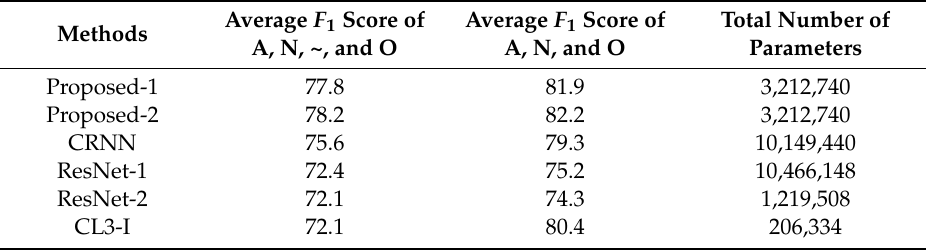
Table 9. Comparison of average F 1 score and total number of parameters of various